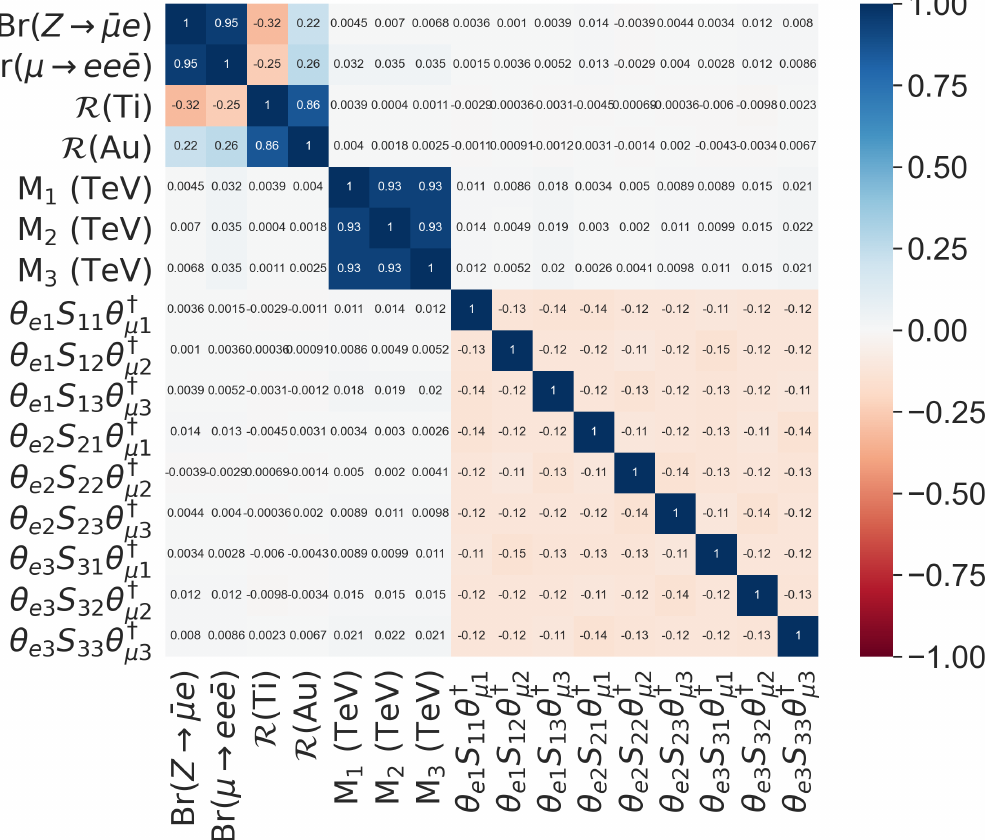
Figure 5 . Heat map that stands for the correlation matrix among ( θSθ † ) eµ − processes: Z → ¯ µe , µ → ee ¯ e , µ − e conversion in nuclei 48